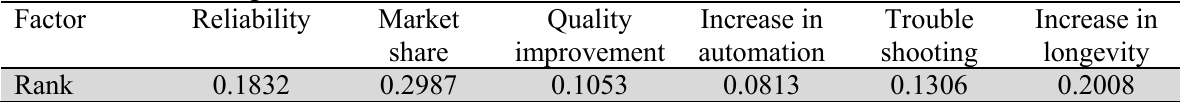
The results of ranking six